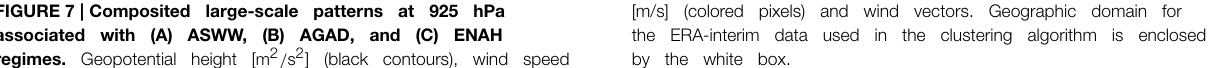
[m/s] (colored pixels) and wind vectors. Geographic domain for the ERA-interim data used in the clustering algorithm is enclosed by the white